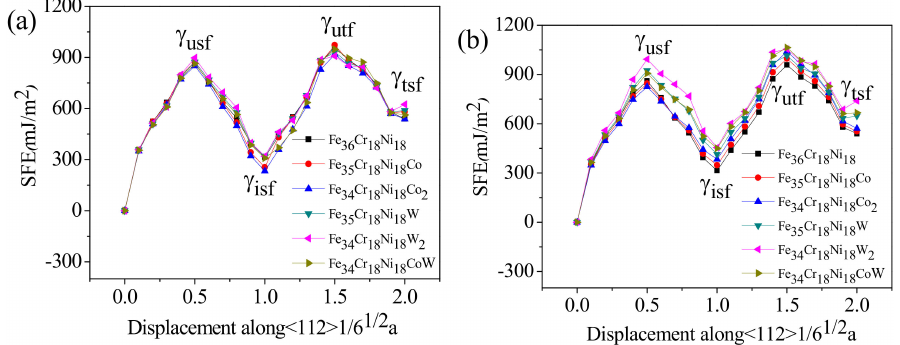
Figure 10. The GSFE curves of di ff erent systems: ( a ) The alloying element is far from the stacking fault region. ( b ) The alloying element locates in stacking fault region.